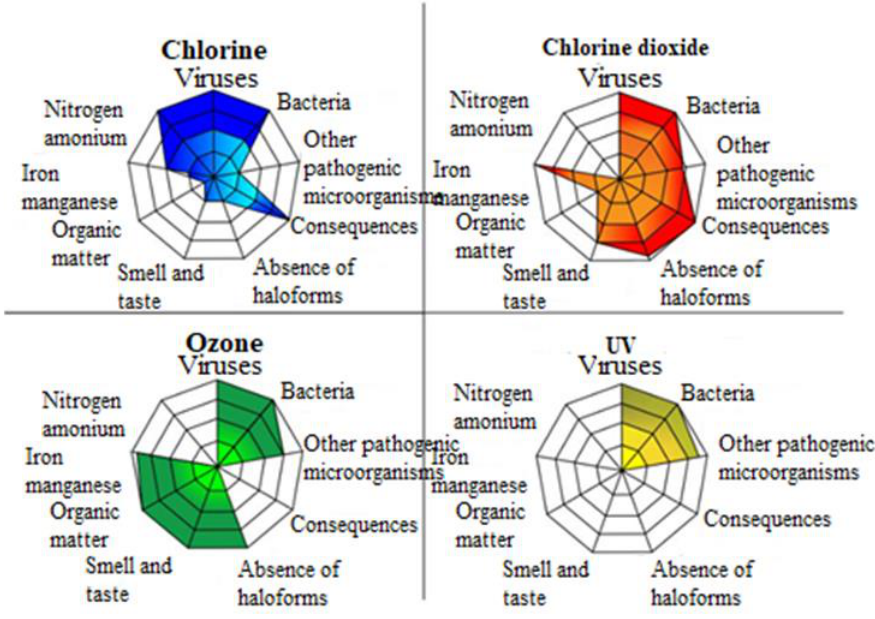
Figure 10. Effectiveness of disinfectants in the process of surface water disinfection.